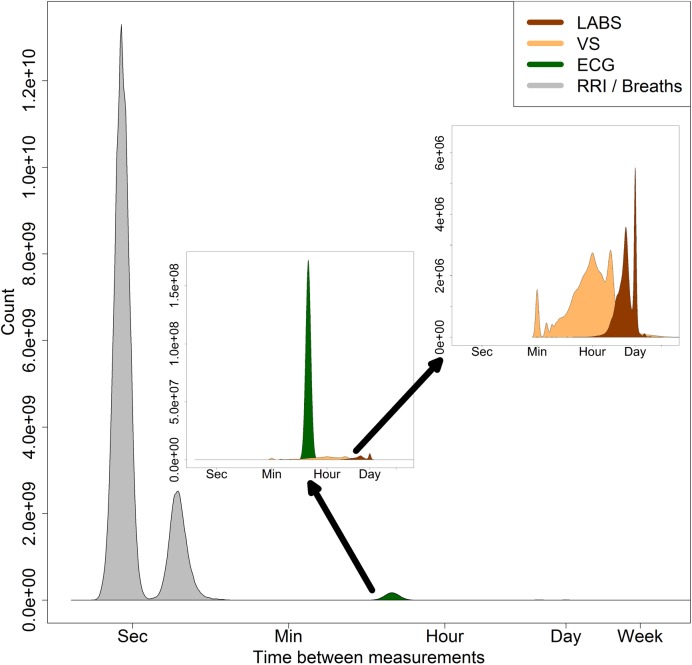
Histograms of the time between measurements, logarithmic scale.The area of each histogram indicates the quantity of measurements available. R wave to R wave (RR) inter-beat and inter-breath intervals (gray) occur on the order of seconds, 2.6 billion heart beats and 600 million breaths. (Middle Inset) Features from the continuous ECG monitors (green) were aggregated at q15 minute increments. (Upper Right Inset) Standard nursing vital signs (yellow) were most frequently obtained at every 1 to 4 hour intervals, 4.1 million measurements. Automated entries into the EMR are evident at every 1 minute. Laboratory results (red) were most frequently measured every 12 hours or daily.